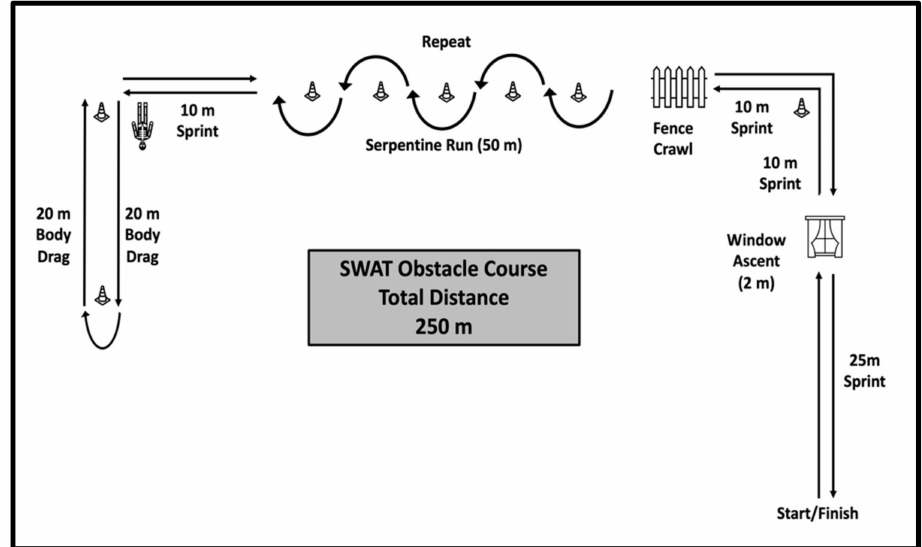
Figure 1. The 250 m SWAT Obstacle